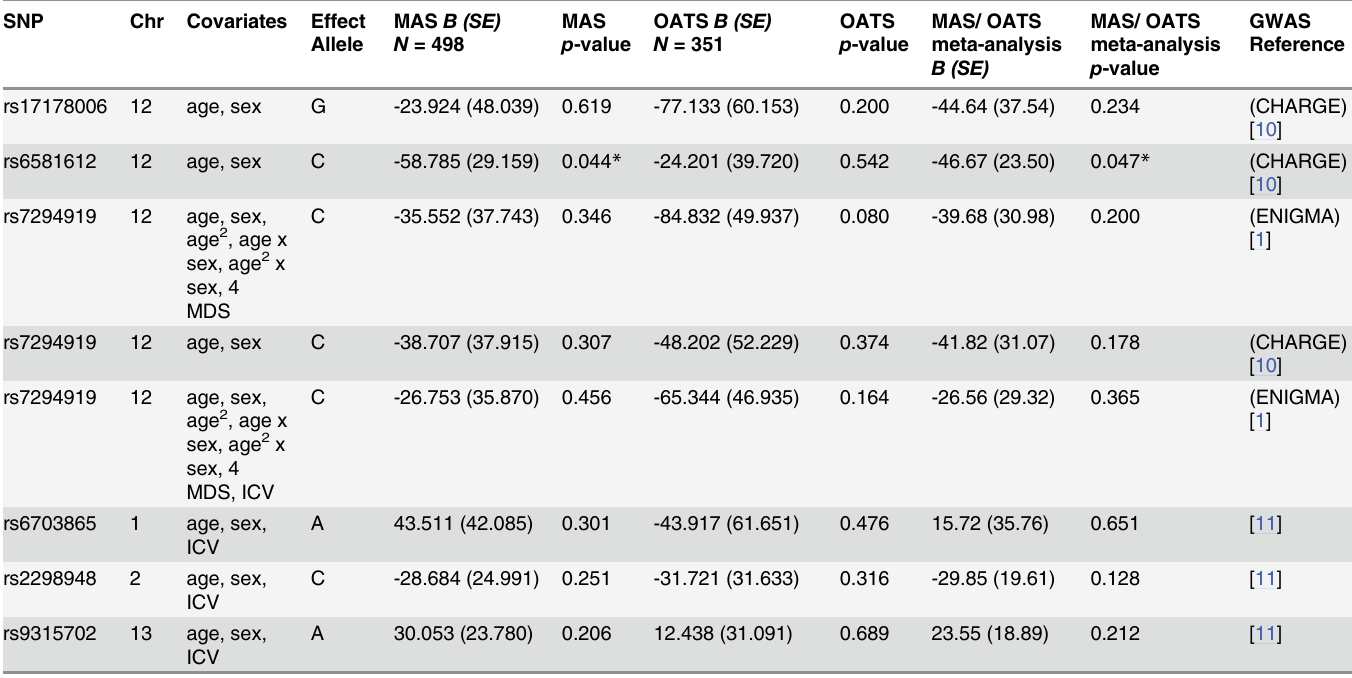
Table 2. Replication results of prior genome-wide signi fi cant HV SNPs for Sydney MAS and OATS by cohort and meta-analysis.